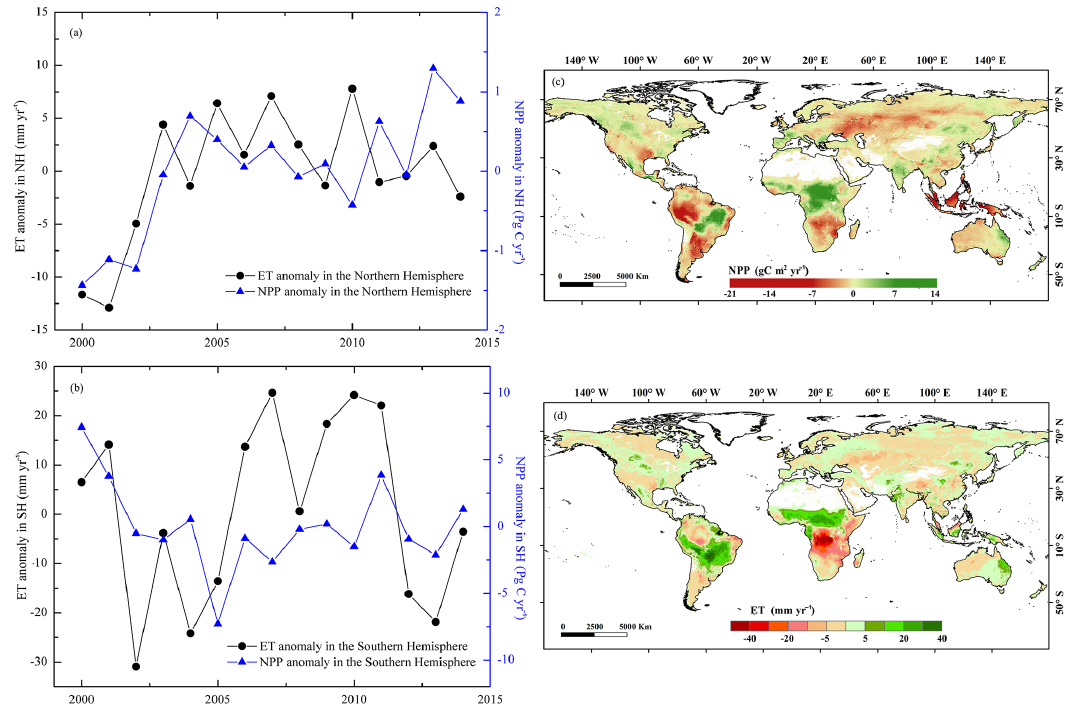
Figure 1. Temporospatial variations in global terrestrial NPP and ET from 2000 to 2014. (a) Interannual variations of NPP and ET in the Northern Hemisphere (NH). (b) Interannual variations of NPP and ET in the Southern Hemisphere (SH). (c) Spatial pattern of NPP trend from 2000 to 2014. (d) Spatial pattern of ET trend from 2000 to